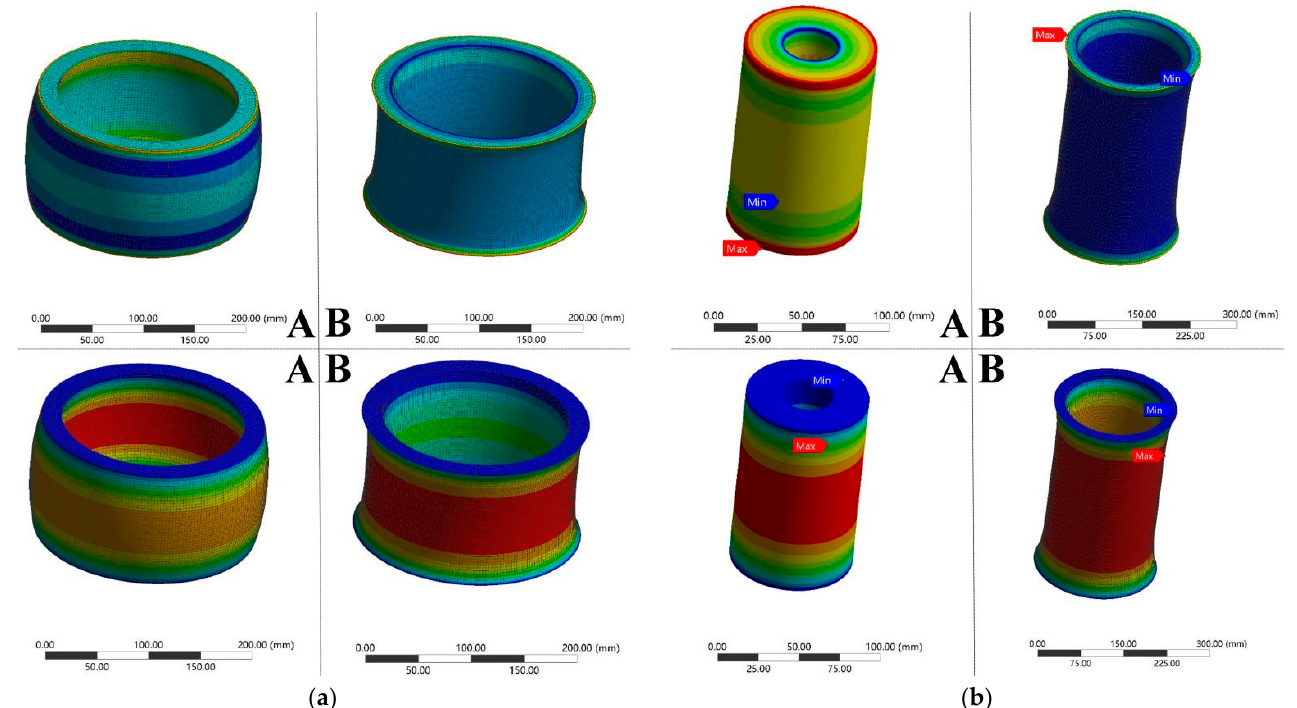
Figure 5. Comparison of stress and strain distribution of cement sheath under different conditions: ( a ) wellbore cement sheath stress/strain distribution changes and ( b ) evaluate the variation in cement sheath stress/strain distribution.